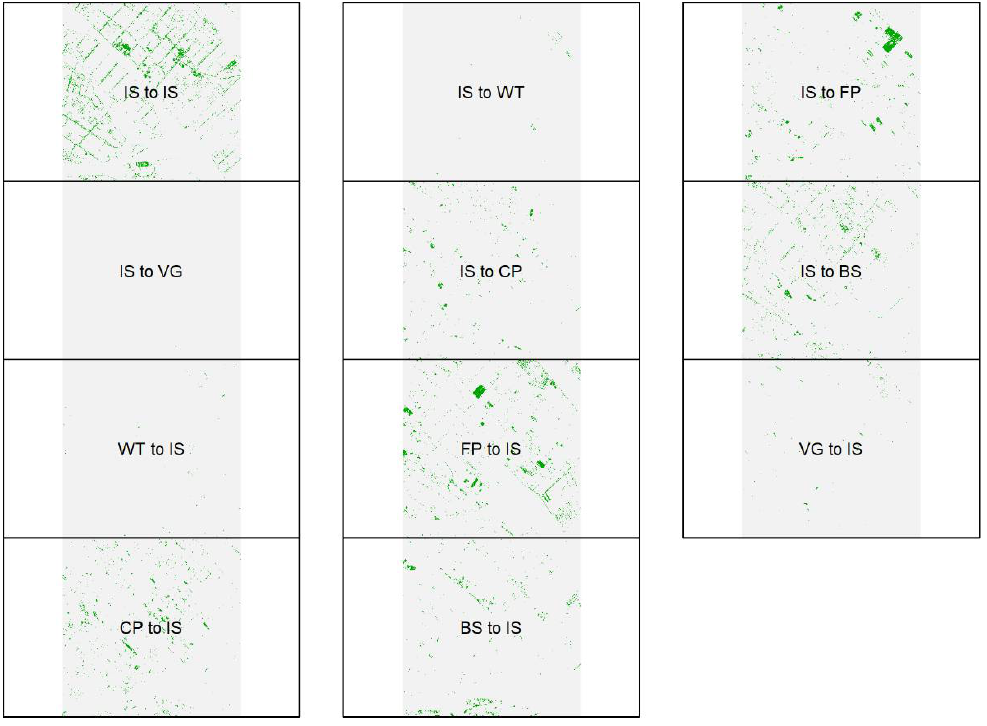
Table 7. The relative likelihood of land cover changes in Region 1 compared to Region 2 (IS, impervious surface; WT, water; FP, fishing ponds; VG, vegetation; CP, crop; BS, bare soil). All of the likelihoods were tested using χ 2 -test and found to have a p -value < 0.05.